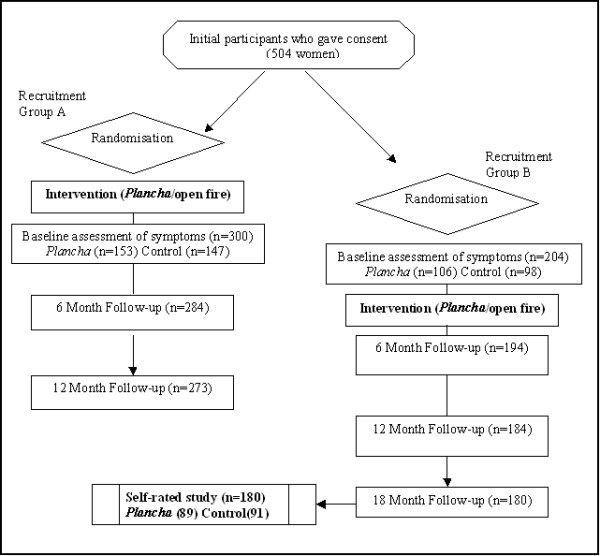
Flowchart of RESPIRE study, and self-rated study.